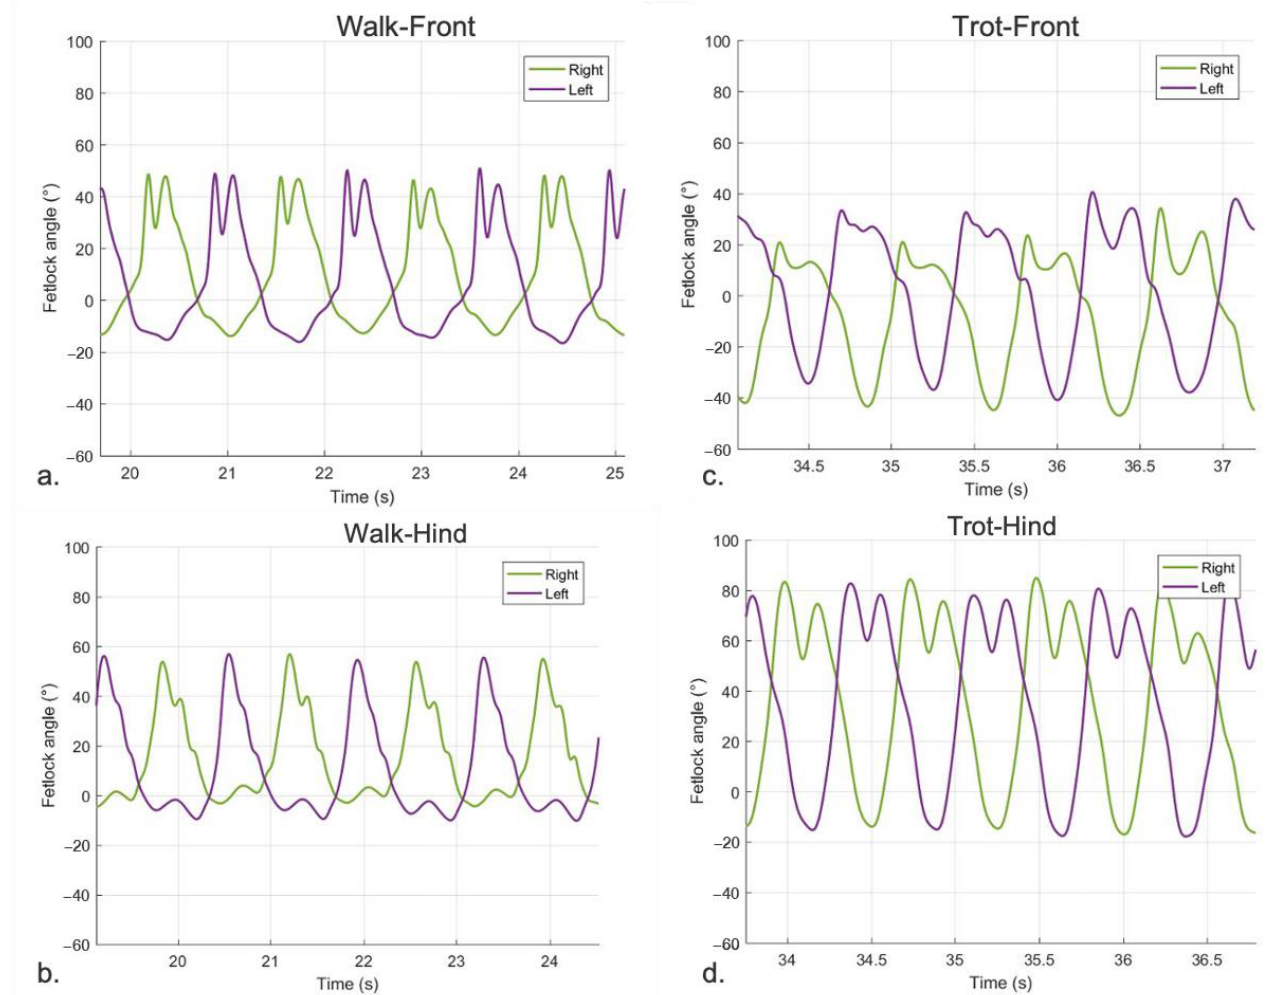
Figure 4. Fetlock joint angle pattern quantified by the MOVIT IMU system in a sound horse over time. Positive values of angles (°) represent flexion and negative values extension of the fetlock joint. ( a ) left front (violet-mean 57.84°) and right front (green-mean 56.72°) at walk; ( b ) left hind (violet-mean 67.01°) and right hind (green-mean 63.55°) at walk; ( c ) left front (violet-mean 78.92°) and right front (green-mean 78.05°) at trot; ( d ) left hind (violet-mean 94.14°) and right hind (green-mean 92.03°) at trot.